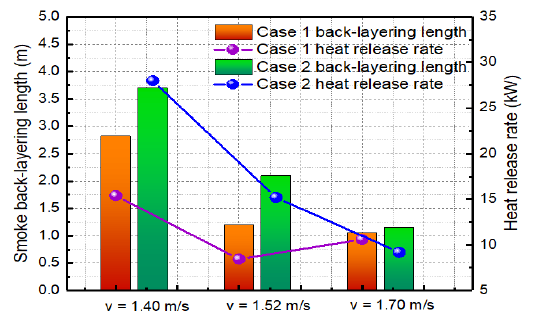
Figure 3. Back-layering length in the ventilation network with parallel branches.